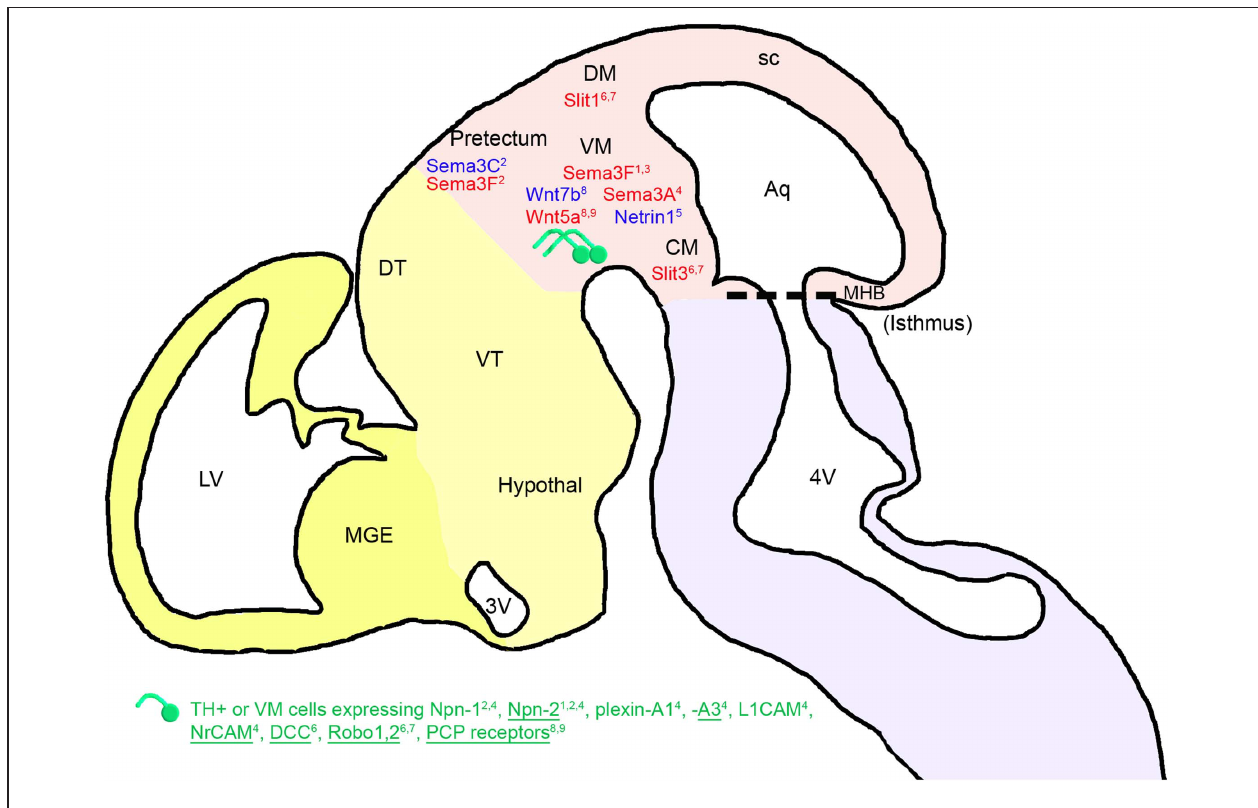
FIGURE 1 | Mesencephalic guidance: expression of repulsive (in red) and attractive (in blue) guidance cues in the environment of mDA somas and axons between E11.5 and E13.5 in mice. mDA axons (in green) navigate in a ventrorostral direction. The expression of guidance molecule receptors in these cells is reported: receptors expressed in all or most of the midbrain TH-expressing cells (TH + ) are underlined, whereas receptors expressed in a small fraction of TH-expressing neurons are not. The expression of these receptors has been determined either at the mRNA or the protein level, for one or several stages of development between E11.5 and E13.5 (see details in the text). FGF8 has an indirect repulsive action on mDA axons through the